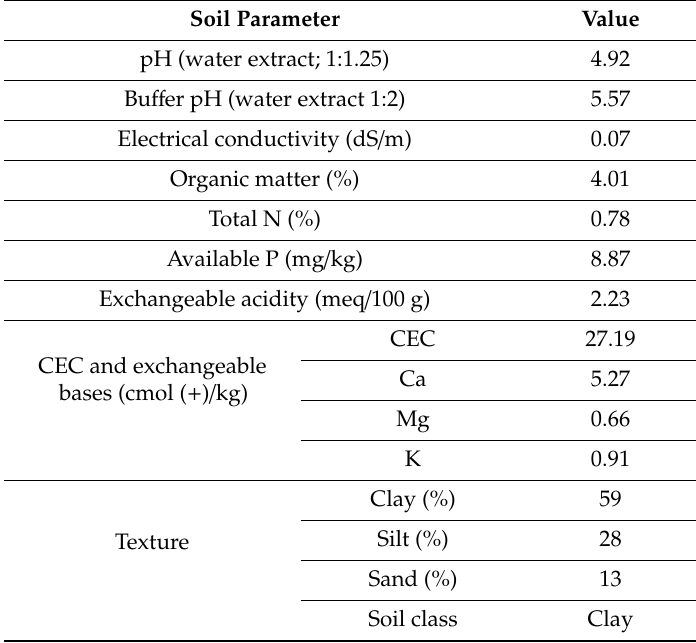
Table 1. Chemical and physical characteristics of the soils of the study